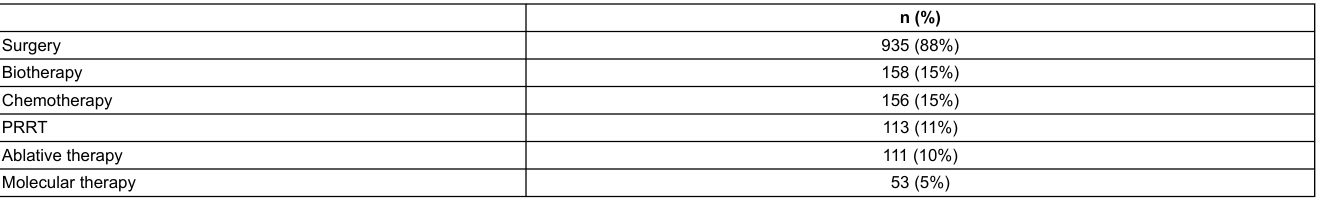
Table 2: Therapies in the main analysis set (n =